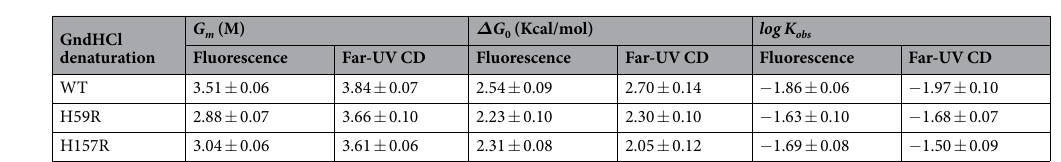
Table 3. Fitted parameters for the chemical unfolding of Pin1-WT, H59R and H157R. C m , the denaturant concentration of GdnHCl at the transition midpoint. Δ G 0 , the free energy of unfolding. log K obs , the unfolding kinetics rate